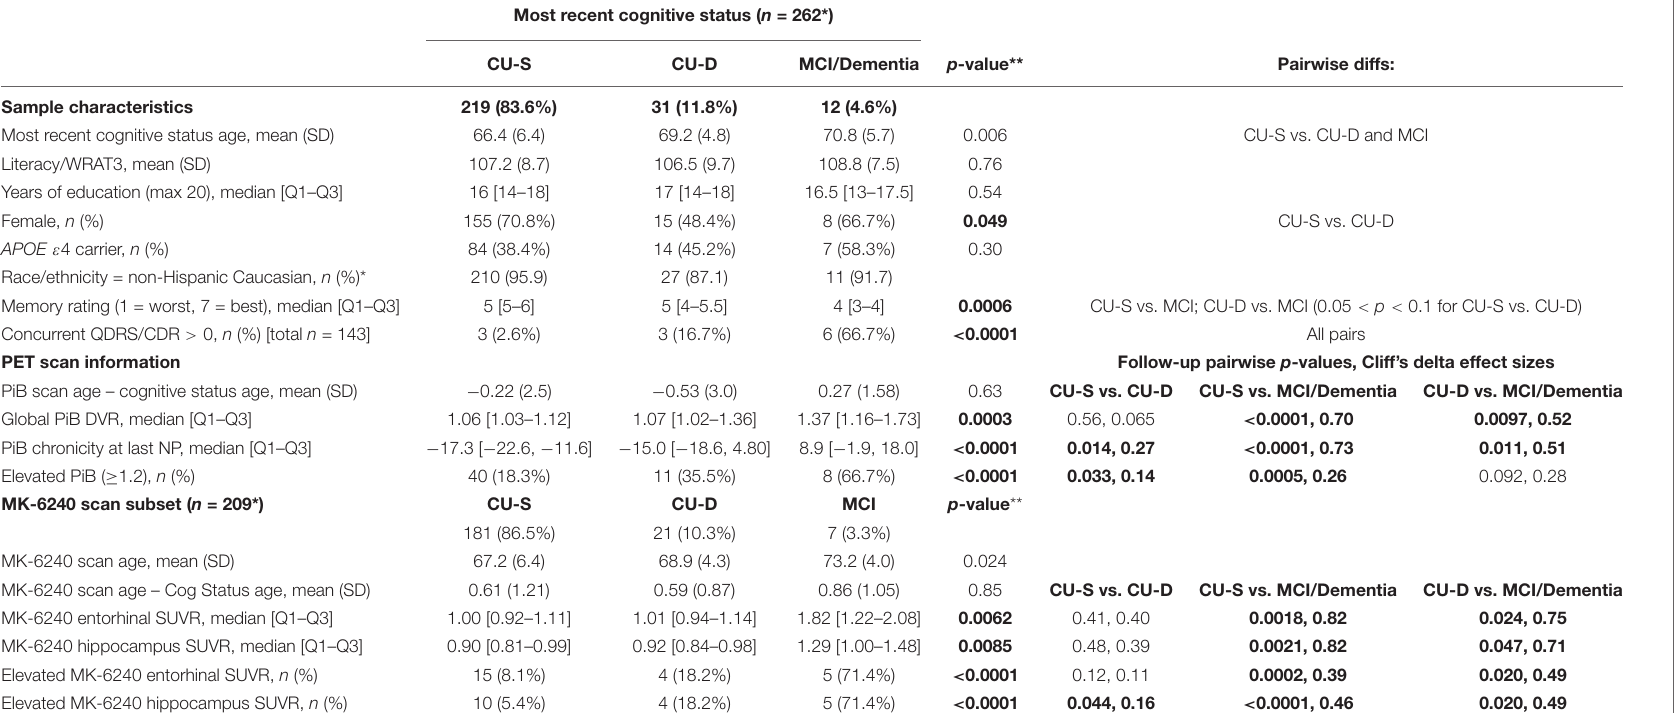
TABLE 6 | PiB and MK-6240 PET subset by most recent cognitive